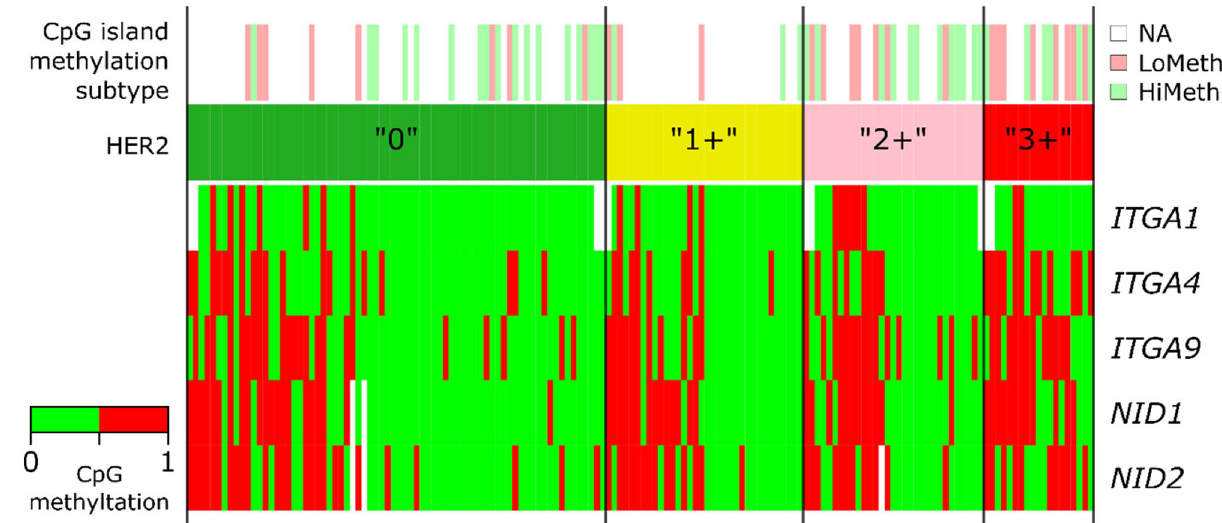
Figure 4. Promoter CpG methylation heatplot for the ITGA1 , ITGA4 , ITGA9 , NID1 , and NID2 genes in the groups of breast cancer samples with different levels of HER2 expression designated as “0”, “1+”, “2+” and “3+” according to the IHC scores. LoMeth and HiMeth (CpG island methylation subtype track) are the moderately methylated and hypermethylated BC subtypes previously assigned to a subset of samples from the same tissue collection on the basis of a genome-wide DNA methylotyping 34 . NA, genome-wide DNA methylotyping data were not generated for the sample. The heatmap demonstrates methylated (red) or nonmethylated (green) statuses of the assessed promoter CpG dinucleotides. Blank fields stand for DNA methylation MSRE-PCR data missing for technical reasons.